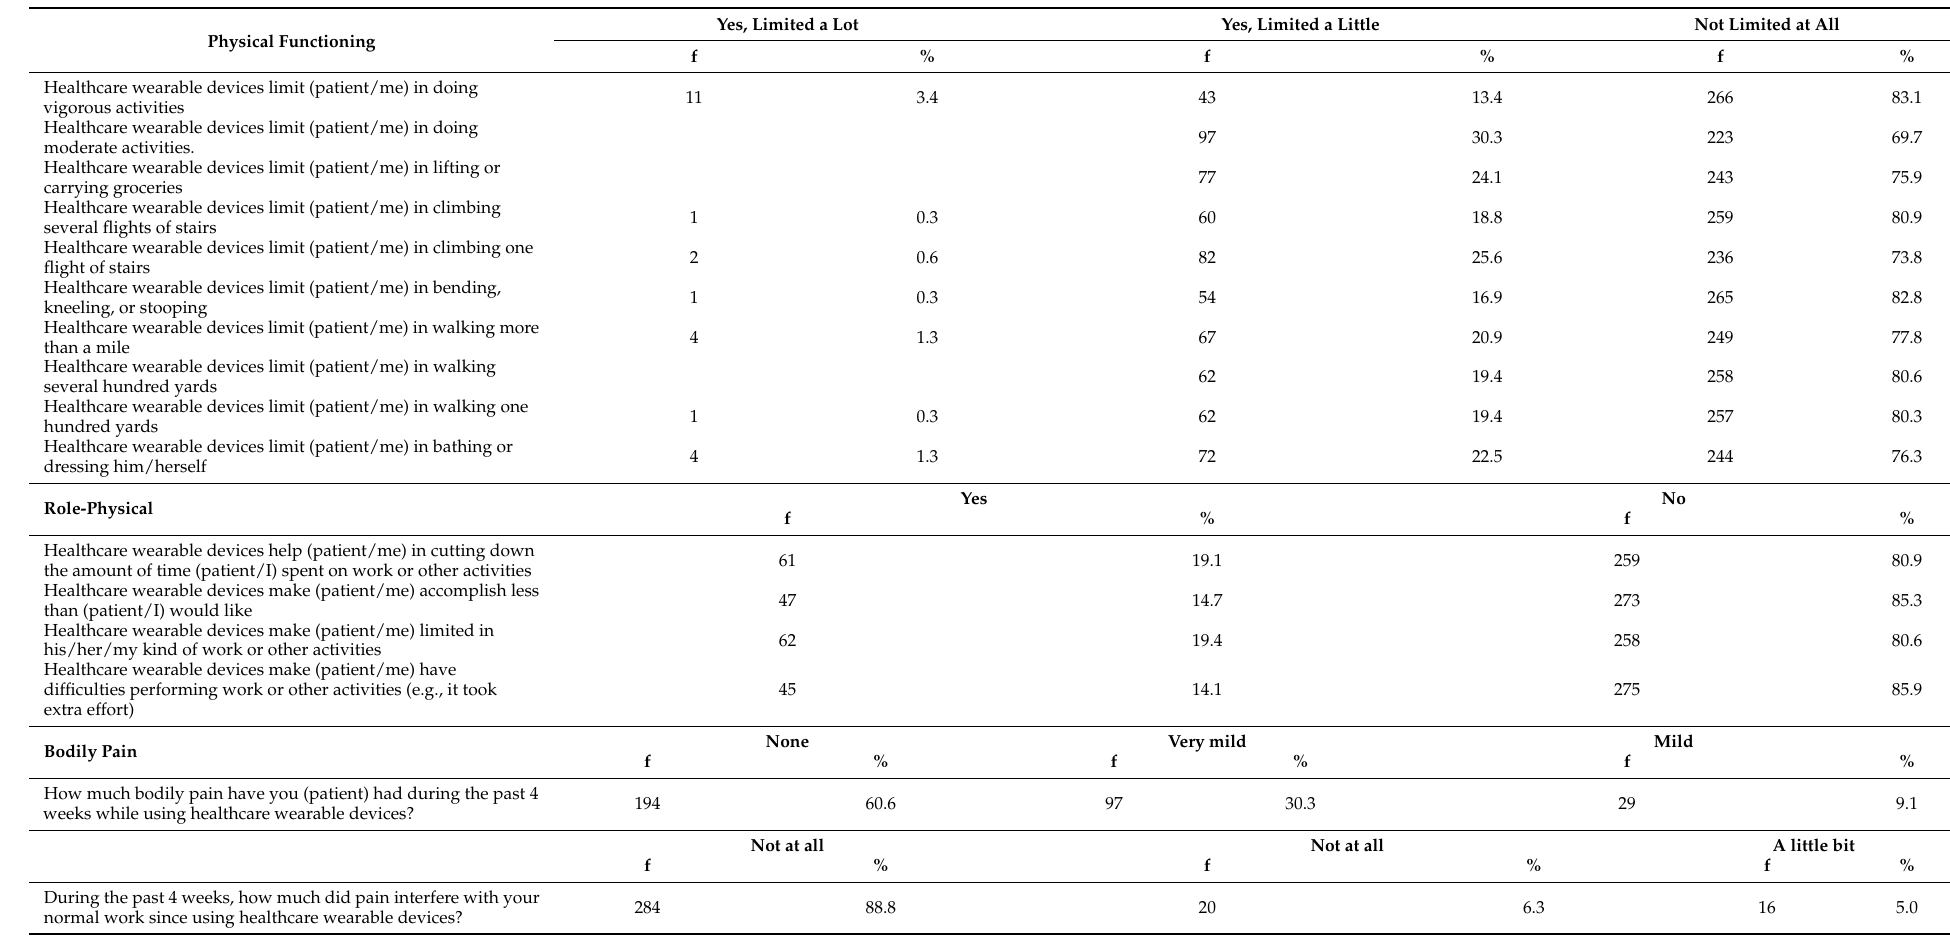
Table A2. Questionnaire items, frequency, and percentage distributions of modified items related to the quality of life (QoL), adapted from Ware 1993 (cid:48) s